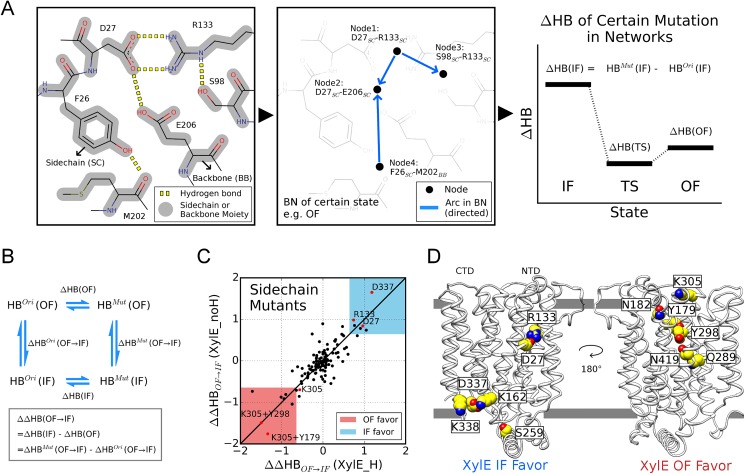
Modeling of causal networks for H-bonds.(A) Schematic diagram of Bayesian network learning and inference (see S7 Fig for details). (Left panel) Non-trivial H-bonds (yellow) are identified for a particular conformation. (Middle panel) A network model is constructed by Bayesian network learning, where H-bonds are abstracted as nodes (black dots) and their causal relationships are represented as directed arcs. (Right panel) In Bayesian network inference, the change in the total amount of H-bond (ΔHB) caused by certain mutations is evaluated for various states. (B) A schematic illustration on the calculation of ΔΔHB, with the mathematical definition shown in the rectangle frame. (C) Identification of side-chain mutants that favor the IF/OF states in XylE systems. The regions that shows strongly IF (ΔΔHBOF→IF > 0.7 for both systems) and OF preference (ΔΔHBOF→IF < -0.7 for both systems) are colored blue and pink, respectively. The mutants mentioned in text are highlighted in red. (D) Single mutations residing in blue and pink area (as well as Lys305) in (C) are presented in the structural view.